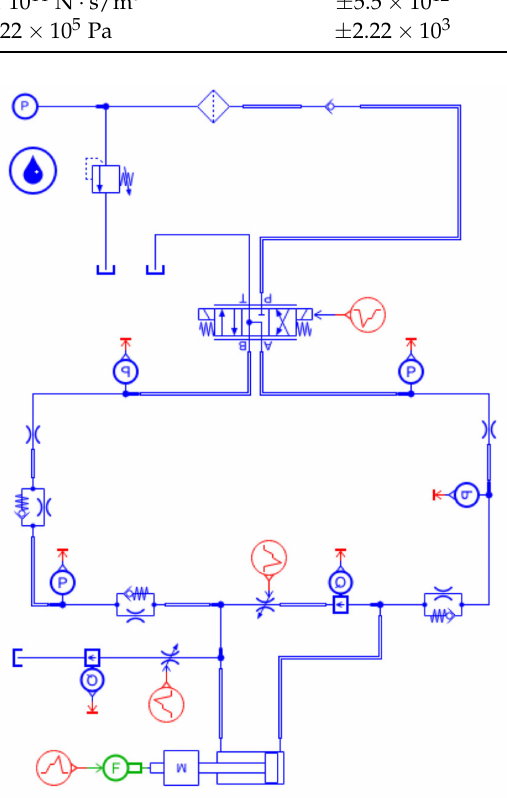
Figure 14. Diagnostic simulation model of the system. As shown in Figure 15, the error bar sampling interval between the simulation effect curve and the absolute ideal curve is 0.001 s. Introducing [48] sum of squares of errors (SSE), mean-squared error (MSE), and model effect evaluation index R 2 :